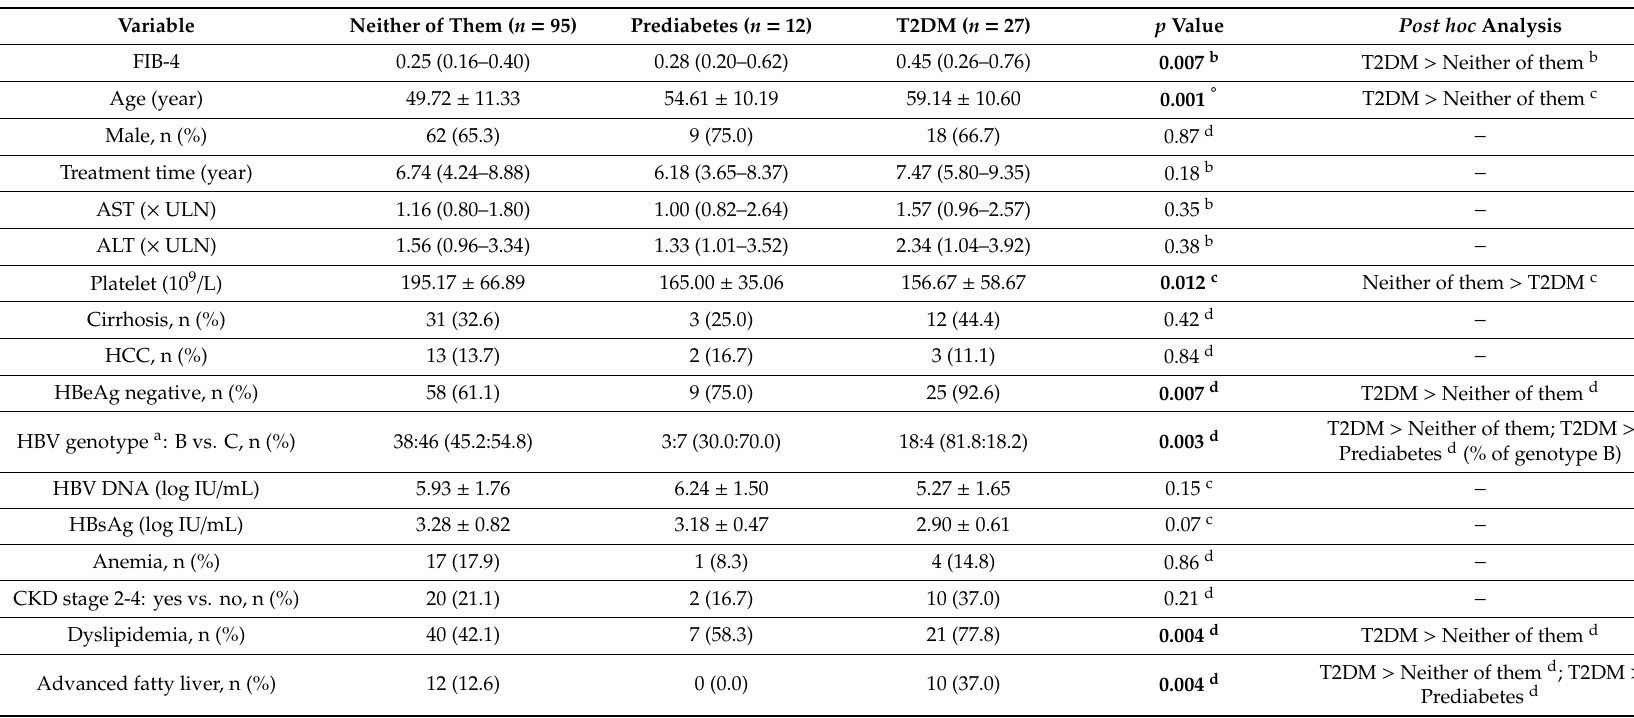
Table 4. In-depth analysis of the baseline fibrosis-4 index and relevant variables among the 134 patients, categorized by prediabetes, type 2 diabetes mellitus (T2DM), or neither of